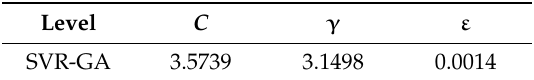
Table 2. The optimum value of parameters in SVR-GA (support vector regression-genetic algorithm) model.